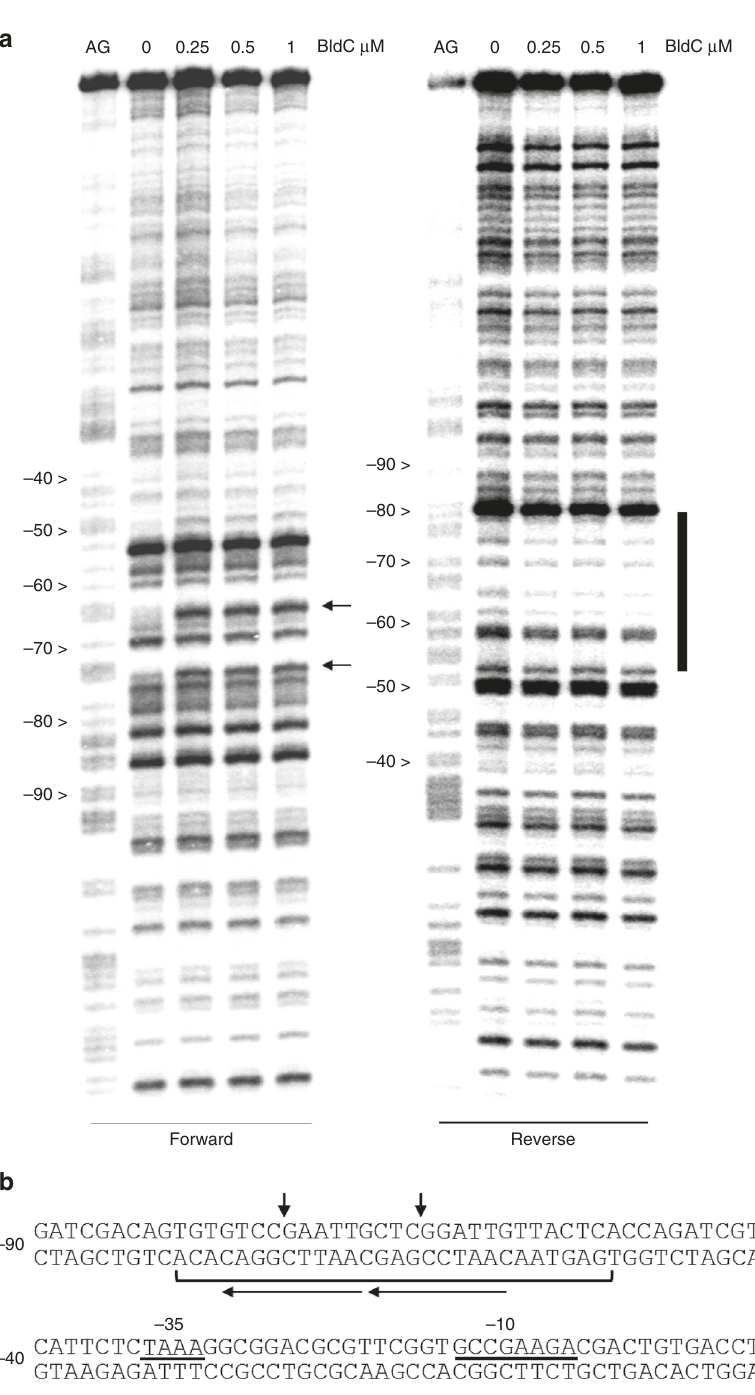
Fig. 2 BldC binding to the whiI promoter region. a DNase I footprinting analysis. 5 ′ end-labeled probes were incubated with increasing amounts of BldC (indicated in µ M above the lanes) and subjected to DNase I footprinting analysis as described in Methods. Footprints are fl anked on the left-hand side by Maxam and Gilbert sequence ladders (AG). Horizontal black arrows indicate sites of enhanced DNase I cleavage on the forward strand and the vertical bar indicates the region of DNase I protection on the reverse strand. b Summary of DNase I footprinting results presented in a . The bracket indicates the protected region and the vertical black arrows indicate sites of enhanced DNase I cleavage. The numbers indicate the distance to the 5 ′ end of the whiI transcript. The direct repeats shown to be bound by BldC in a head-tail orientation are indicated by arrows (with arrows pointing in the head-tail